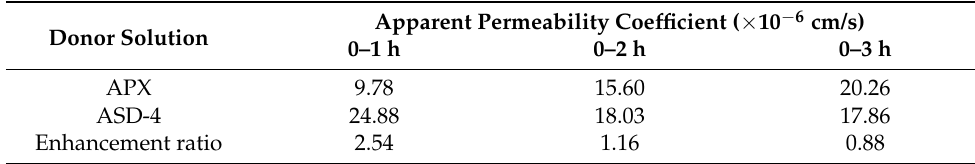
Table 5. Apparent permeability coefficient (P app ) of pure APX and